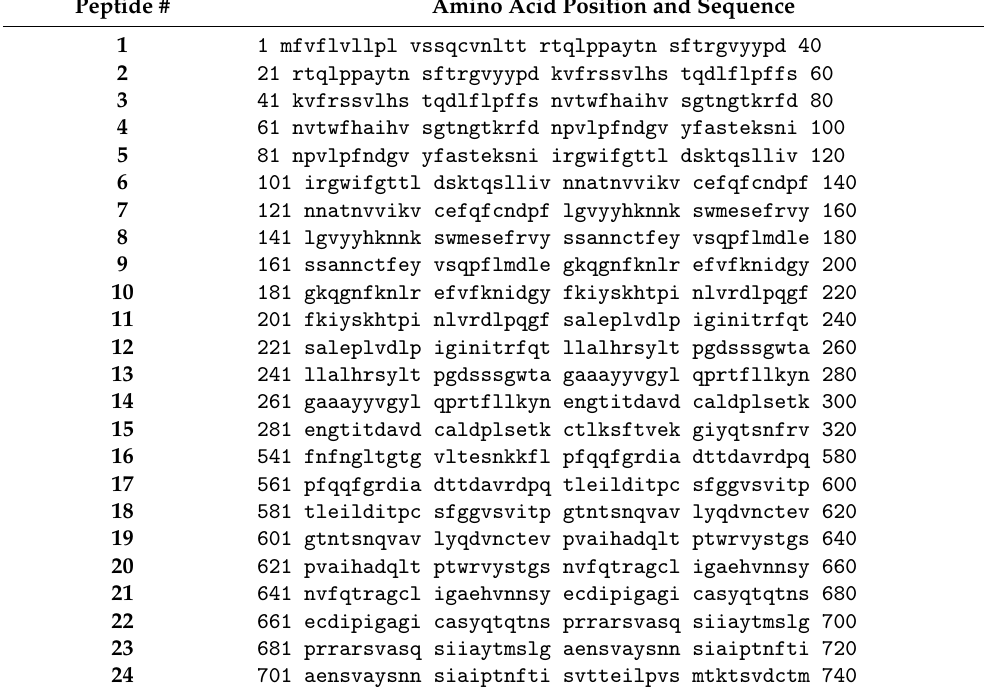
Table 2. List of synthetic peptides of 40 aa in length (with 20 aa overlaps between sequential peptides), covering the S1 domain and the N-terminal portion of the S2 domain in order to finely characterize the epitope recognized by our anti-S